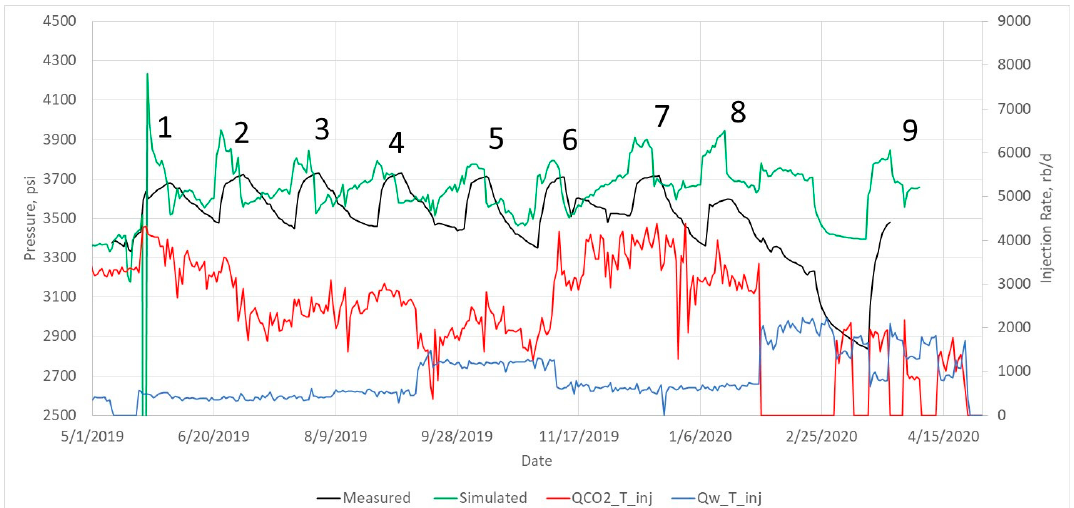
Figure 6. Total injection and BHP measured for the pilot study. The black curve shows the measured bottom-hole pressure data. The green curve shows simulated results from the base case model. Values for CO 2 and water injection rates (red and blue curves) are indicated on the secondary axis